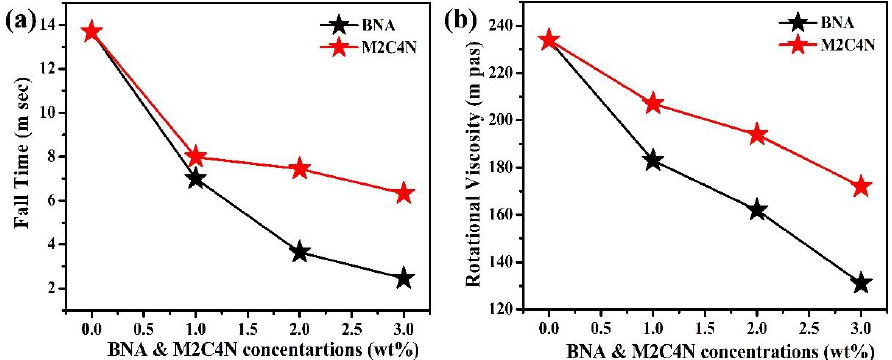
Figure 5. ( a ) τ o ff and ( b ) γ of BNA and M2C4N-doped LC Figure 5. ( a ) τ off and ( b ) γ of BNA and M2C4N-doped LC cells. Table 2. Calculated μ , α , Δ α, and ΔE of 5CB, BNA, 5CB + BNA, M2C4N, and 5CB + M2C4N molecules via Gaussian 09-DFT methods.